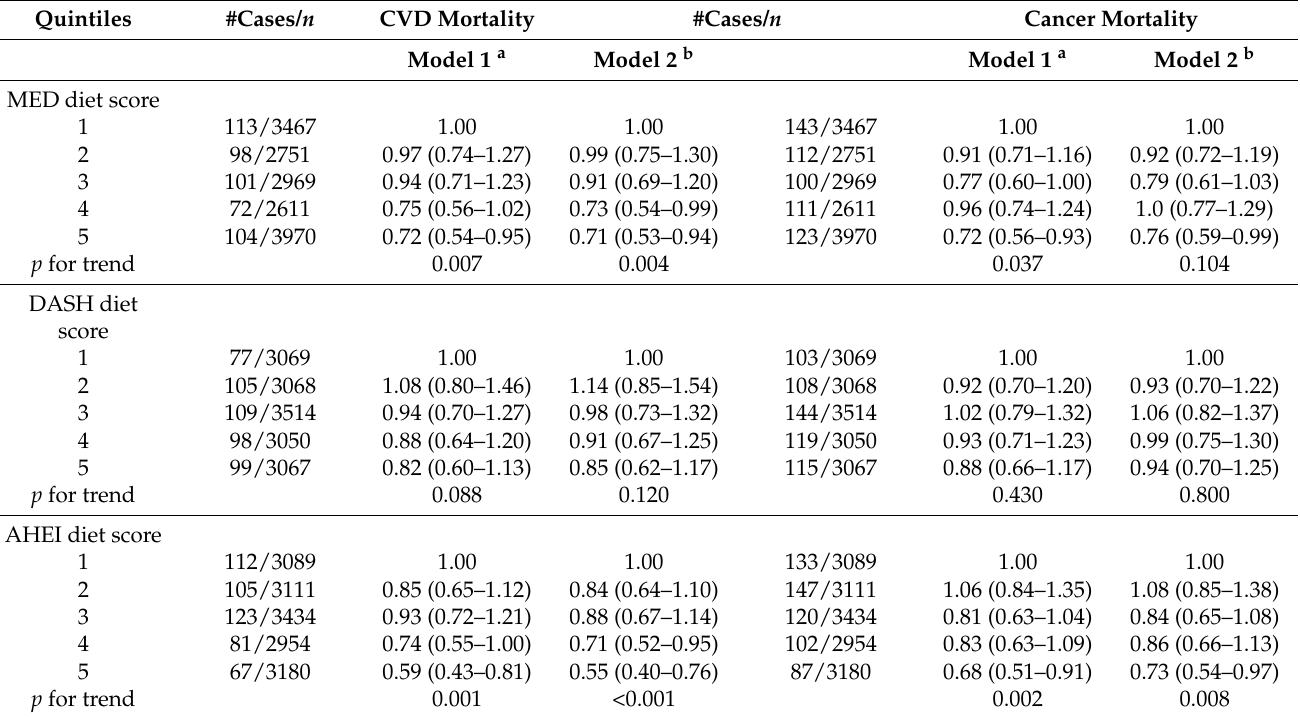
Table 3. HR (95% CIs) for CVD and cancer mortality according to quintiles of MED, DASH, and AHEI scores among 15,768 men in the Physicians’ Health